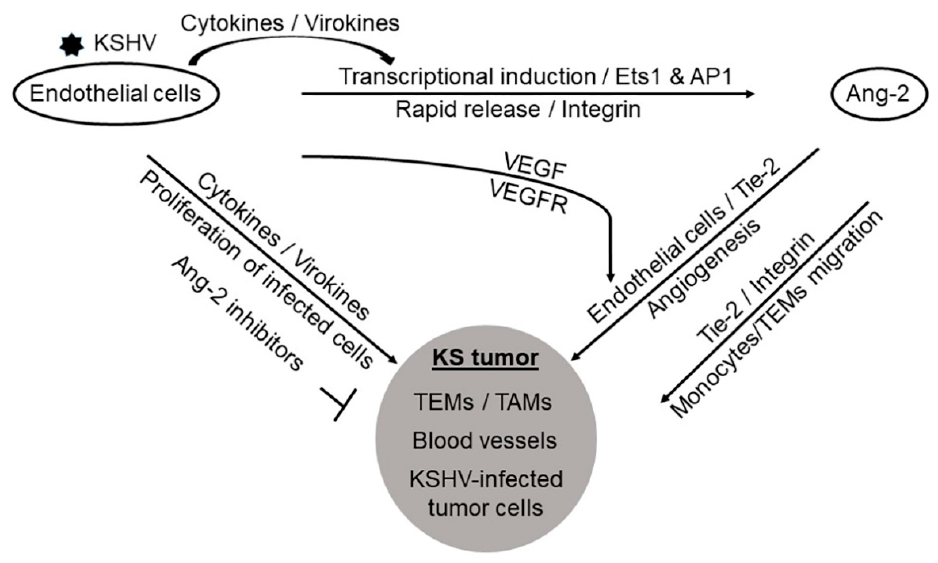
Figure 3. KSHV-induced Ang-2 promotes angiogenesis, inflammation, and KS tumor development. KSHV acute infection of endothelial cells strongly induces Ang-2 transcription via activation of the transcription factors Ets1 and AP1, and triggers its rapid release through integrin signaling. The KSHV-induced Ang-2 acts on uninfected endothelial cells to promote angiogenesis in collaboration with KSHV-induced VEGF, and stimulates chemotaxis and migration of monocytes and TEMs towards the infection sites. Proliferation of the KSHV-infected endothelial cells, extensive blood vessels, and infiltration of inflammatory cells are hallmarks of KS tumors. The effective inhibition of KS tumor growth in nude mice by Ang-2 inhibitors strongly suggests that Ang-2 plays a pivotal role in KS tumor